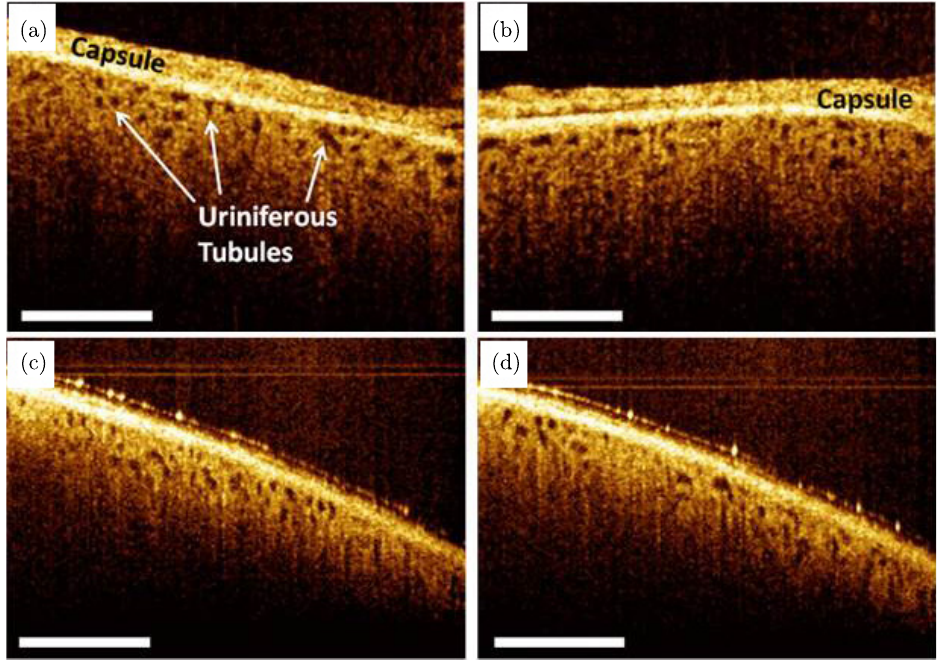
Fig. 3. OCT imaging of human kidneys following transplantation showing open uriniferous tubules below the renal capsule in two di®erent patients ((a) and (b) are for one patient and (c) and (d) are for another). Tubules appear to be fairly open and round with some degree of homogeneity throughout the images. Scale bar ¼ 500 (cid:1) m.